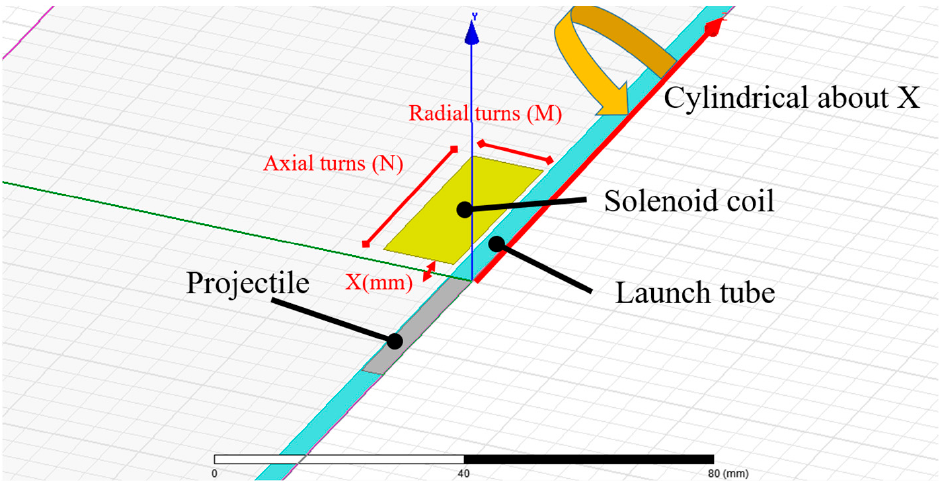
Figure 4. The axisymmetric 2D model of coil gun in MAXWELL. Table 1. The ranges of design variables for single-stage coil guns by copper wire diameter. Table 2. Results of the finite element analysis giving optimal coil gun shapes according to the copper wire